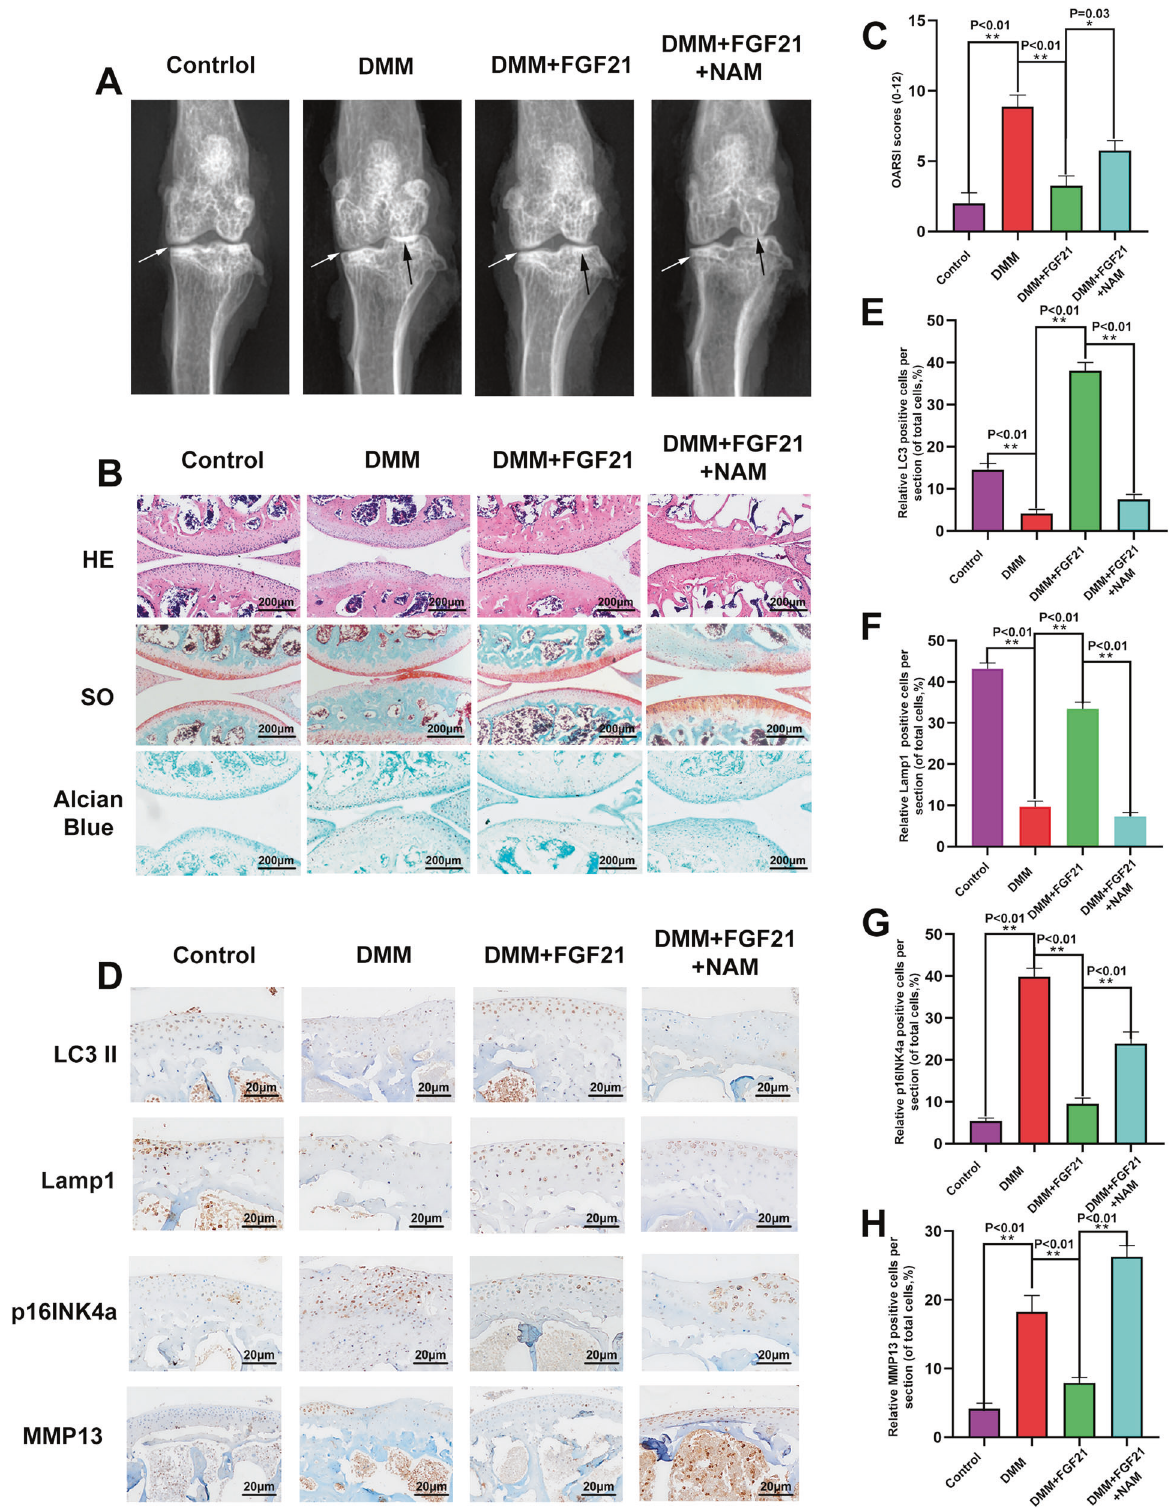
Fig. 8 FGF21 inhibited OA progression in the DMM mouse model via the SIRT1-mTOR signaling pathway. A Shown are the digital X-ray images of the mouse knee joints from different groups. B Shown are the representative H&E, S-O, and Alcian Blue staining of cartilage in each group, 8 weeks after the surgery (scale bar: 200 μ m). C Shown are the OARIS scores for the cartilages in each group. D – H Shown are the expressions of LC3, Lamp1, p16INK4a, and MMP13, evaluated using immunohistochemistry staining (scale bar: 20 μ m). Signi fi cant differences between the treatment and control groups are indicated as ** P < 0.01 and * P < 0.05, n =